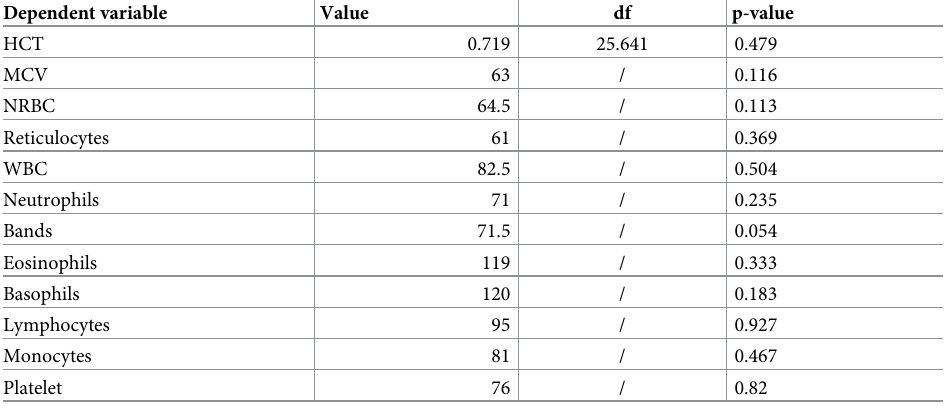
Table 4. Effect of the presence of neoplasia on CBC findings in FeLV positive cats compared to those without neoplasia.